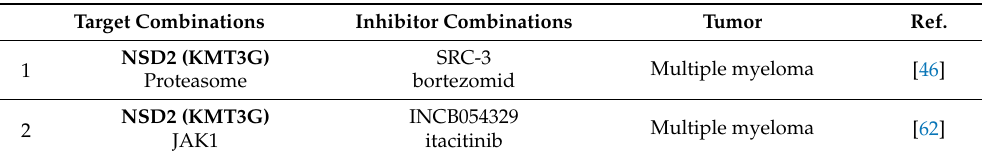
Table 1. Candidate combinations for synthetic lethality strategies targeting chromatin methylases (KMT) and demethylases